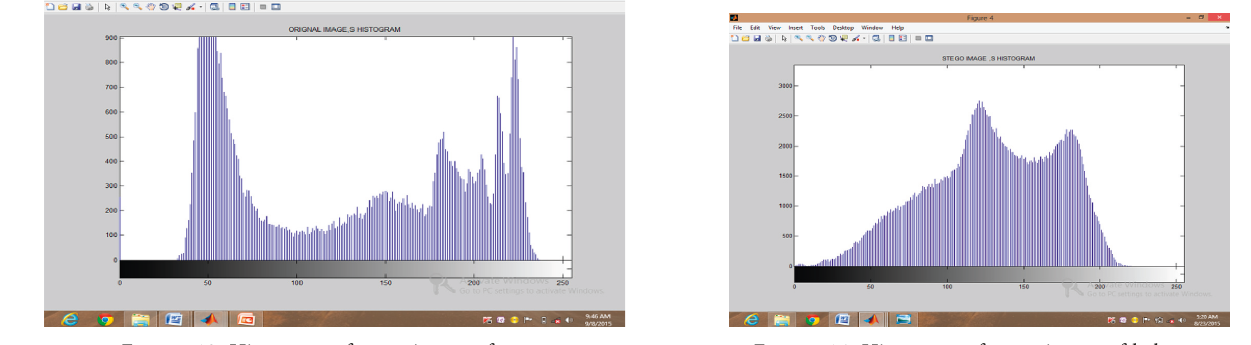
Figure 14: Histogram of stego image of